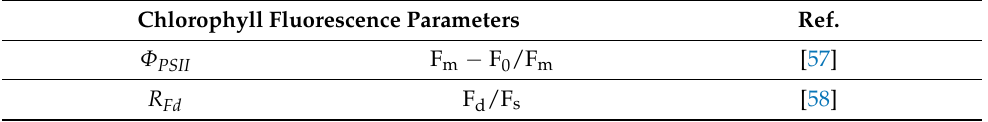
Table 7. The photochemical quenching